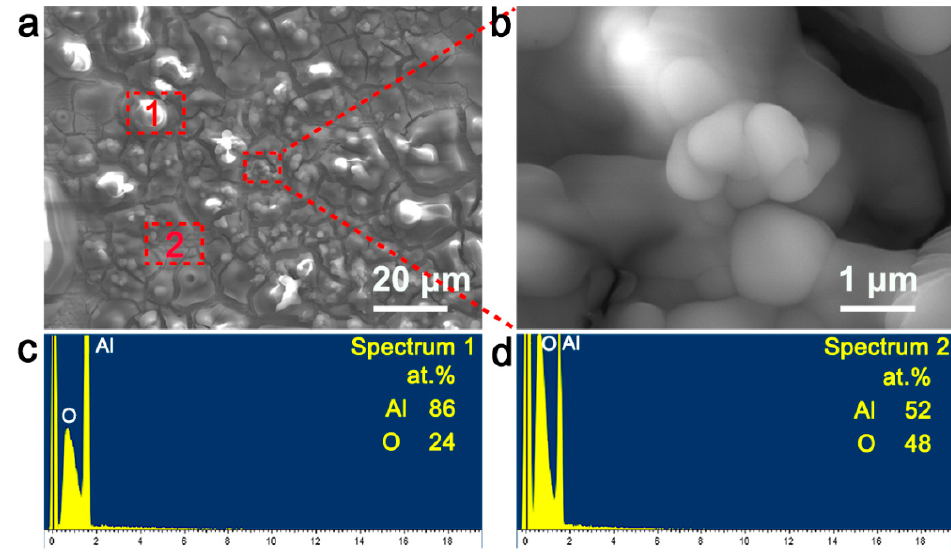
Figure 5. Surface morphology of black area in Figure 4b at magnitudes of ( a ) 1000× and ( b ) 20,000×, and ( c , d ) EDS spectrum of corresponding area of points 1 and 2.